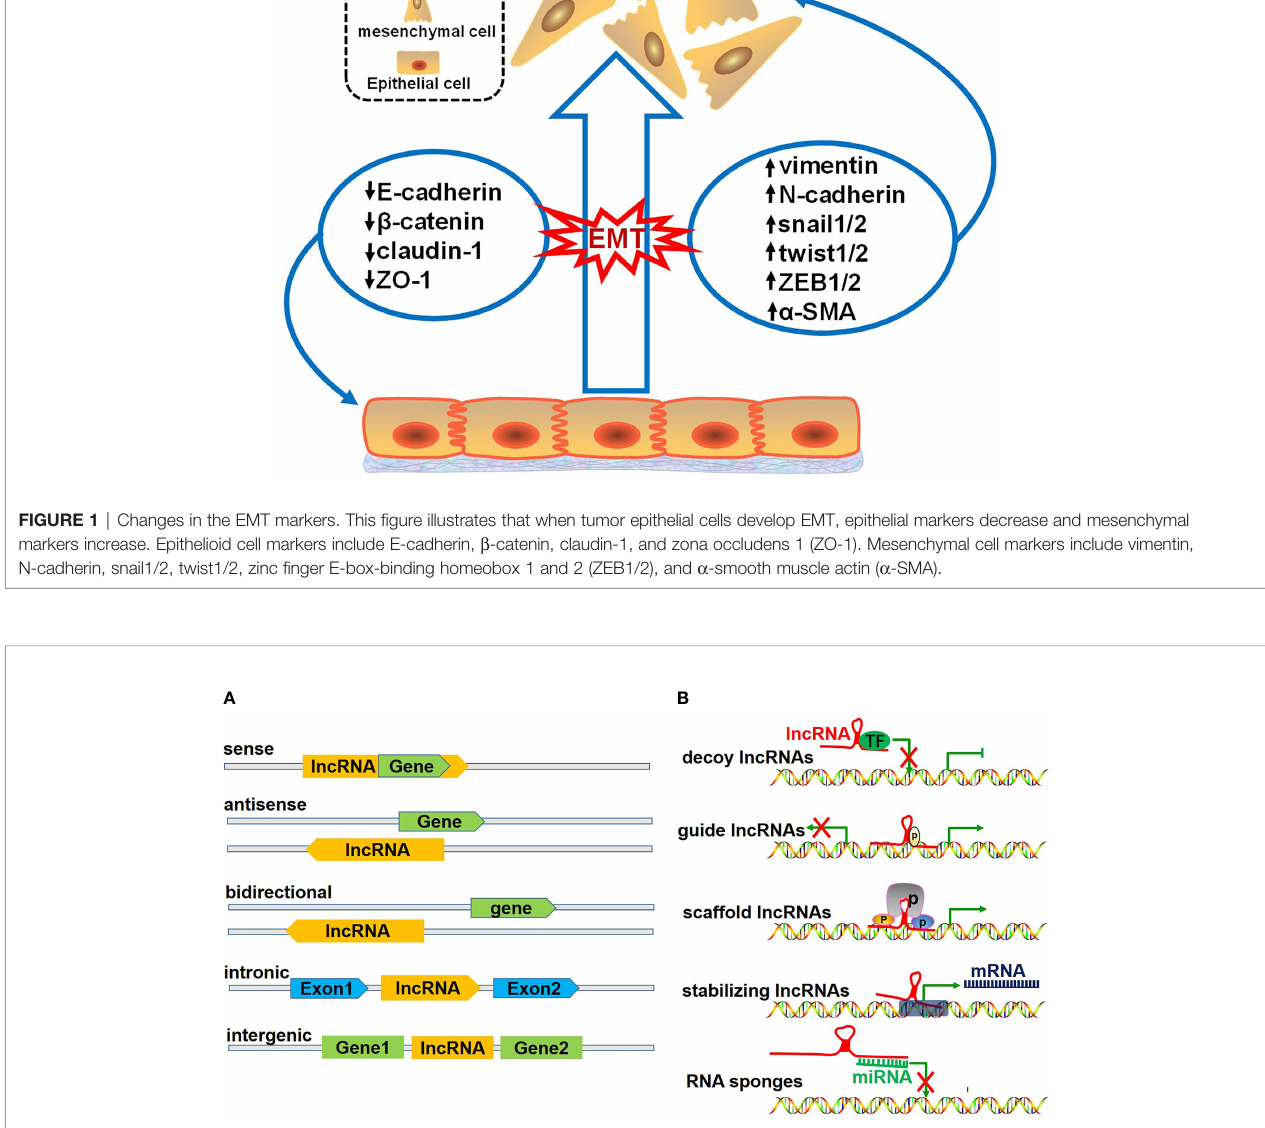
FIGURE 2 | Classi fi cation of lncRNAs. (A) illustrates the classi fi cation of lncRNAs according to the position of lncRNAs in the genome relative to the coding protein gene, including 1) sense lncRNAs, overlapping with coding mRNAs on the coding DNA strand, 2) ant-sense lncRNAs, overlapping with coding mRNAs on the noncoding DNA strand, 3) bidirectional lncRNAs, sharing their transcription initiation sites with noncoding DNA on the contrary strand, 4) intronic lncRNAs, being transcribed from an intronic region of coding DNA, and 5) intergenic lncRNAs, being located between coding DNA. (B) shows the classi fi cation of lncRNAs according to their functions, including 1) decoy lncRNAs, sequestering proteins to restrict combination with target genes, 2) guide lncRNAs, recruiting chromatin remodeling agents to precise gene loci, 3) scaffold lncRNAs, facilitating protein complex formation, 4) stabilizing lncRNAs, binding target mRNA transcripts and stabilizing and promoting their translation,